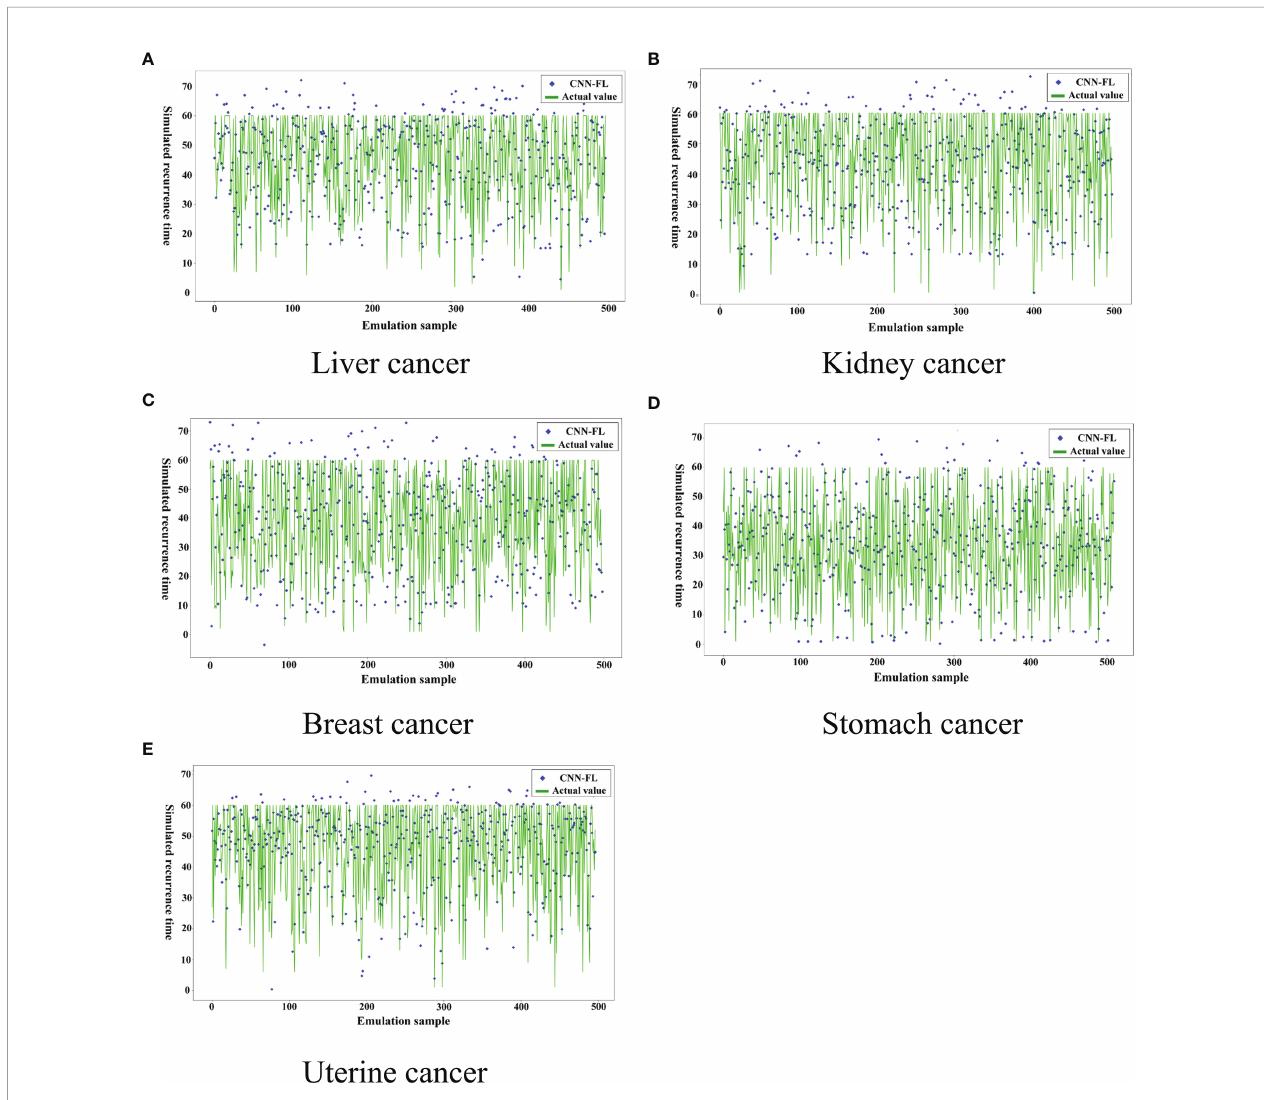
FIGURE 6 | Recurrence time model of cancer assisted diagnosis based on federated